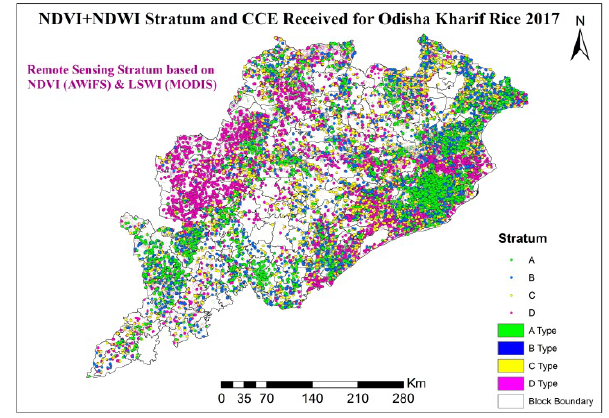
Figure 3: Stratum wise CCE distribution in Odisha in 2017-18 Yield